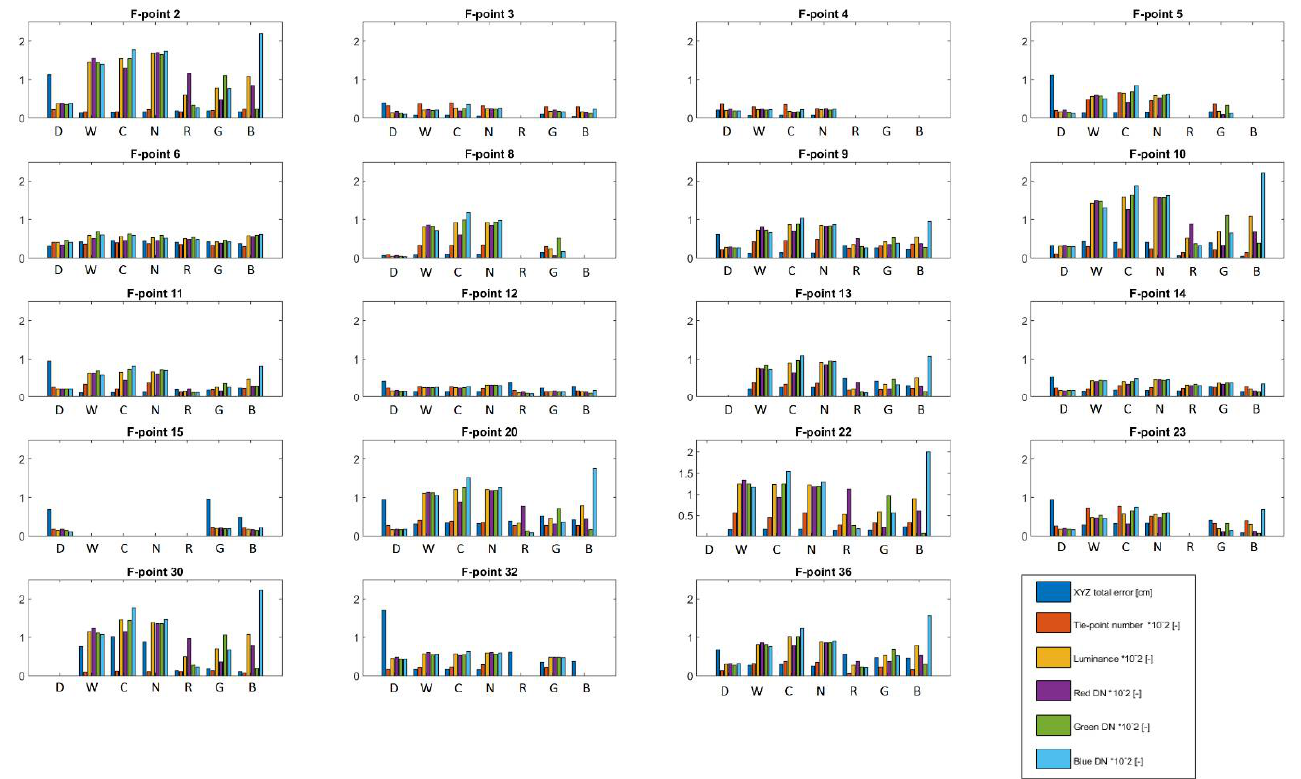
Figure 9. Graphic list of F-point features by study (horizontal axis—study type designations: D—dark, W—warm, C—cold, N—neutral, R—red, G—green, B—blue).